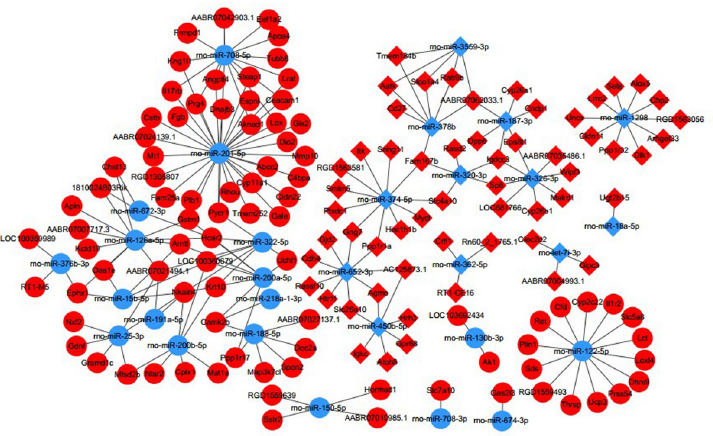
Fig 5. Integrated miRNA-mRNA analysis. The top 200 most negatively correlated putative miRNA-mRNA pairs ( P < 0.05). Light blue circle indicates up-regulated miRNAs and red circle indicates down-regulated mRNAs. Light blue square indicates down-regulated miRNAs and red square indicates up-regulated